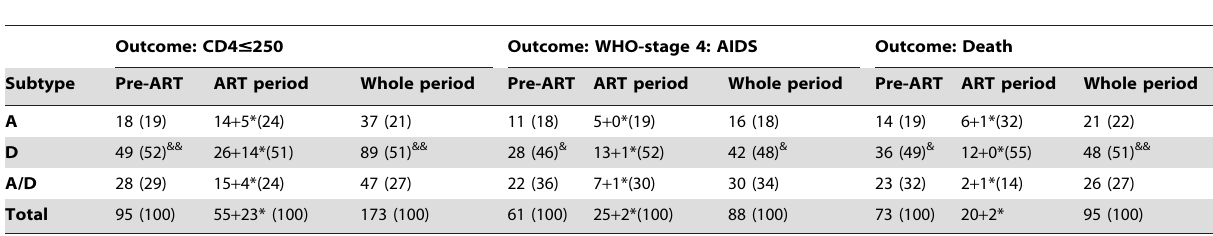
Table 3. Number (proportion (%)) of participants progressing to each outcome by HIV-1 subtype.